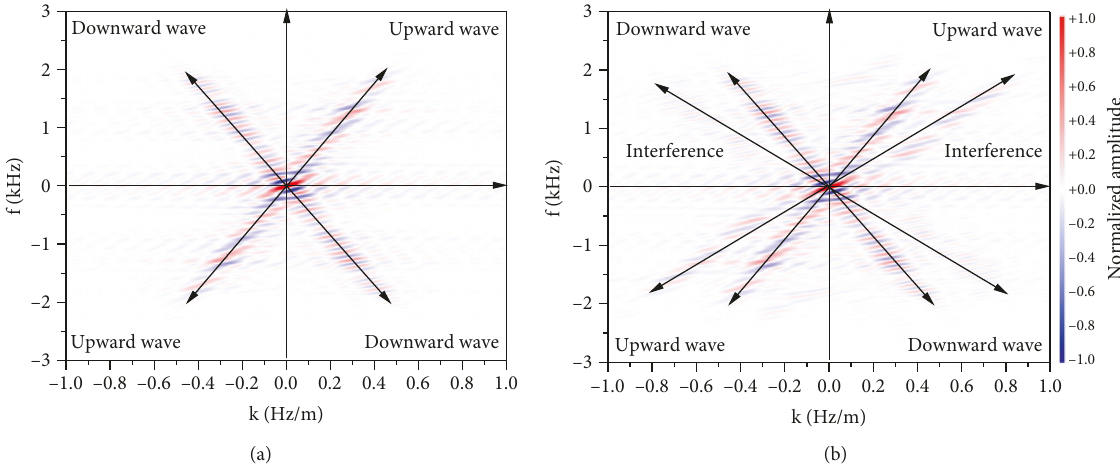
Figure 12: Results of frequency-wavenumber domain analysis (impact location x